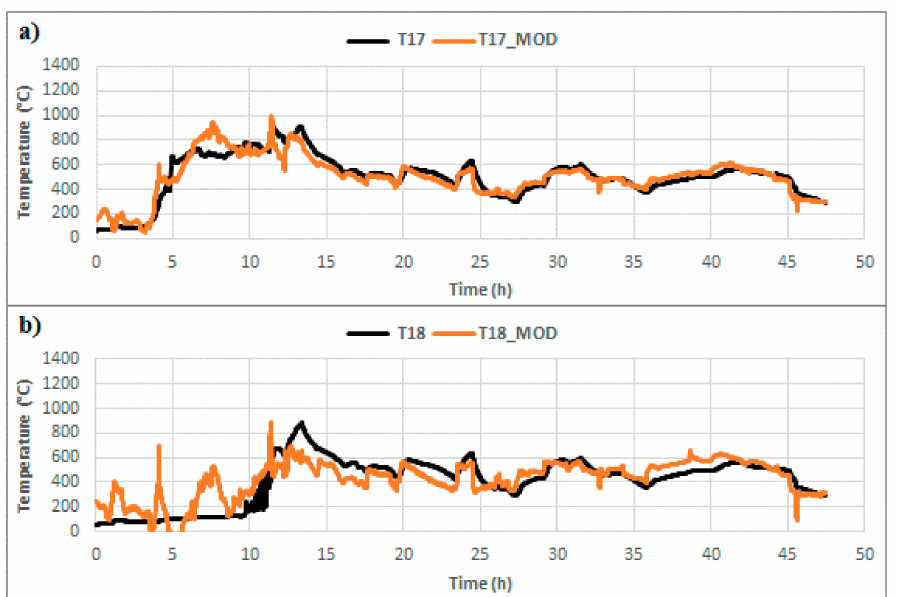
Figure 11. The measured (T) and modelled (T_MOD) temperature behavior, ( a ) temperature T 17 , ( b ) temperature T 18 (Source: own